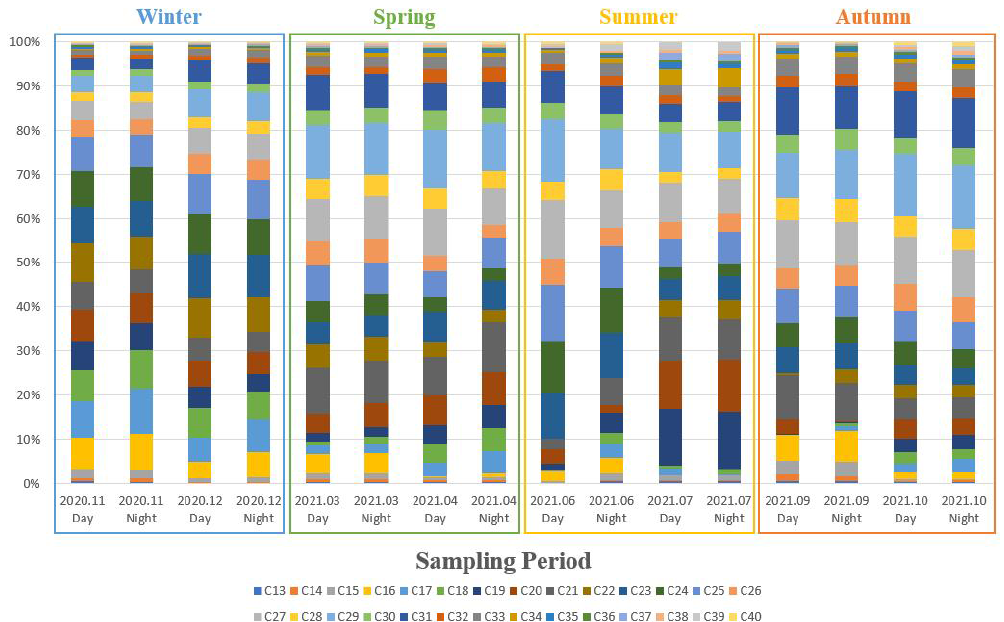
Figure 3. Contributions of particulate-bound n -alkane homologs to the total n -alkane concentrations in the day and night samples in the different seasons of Beijing.